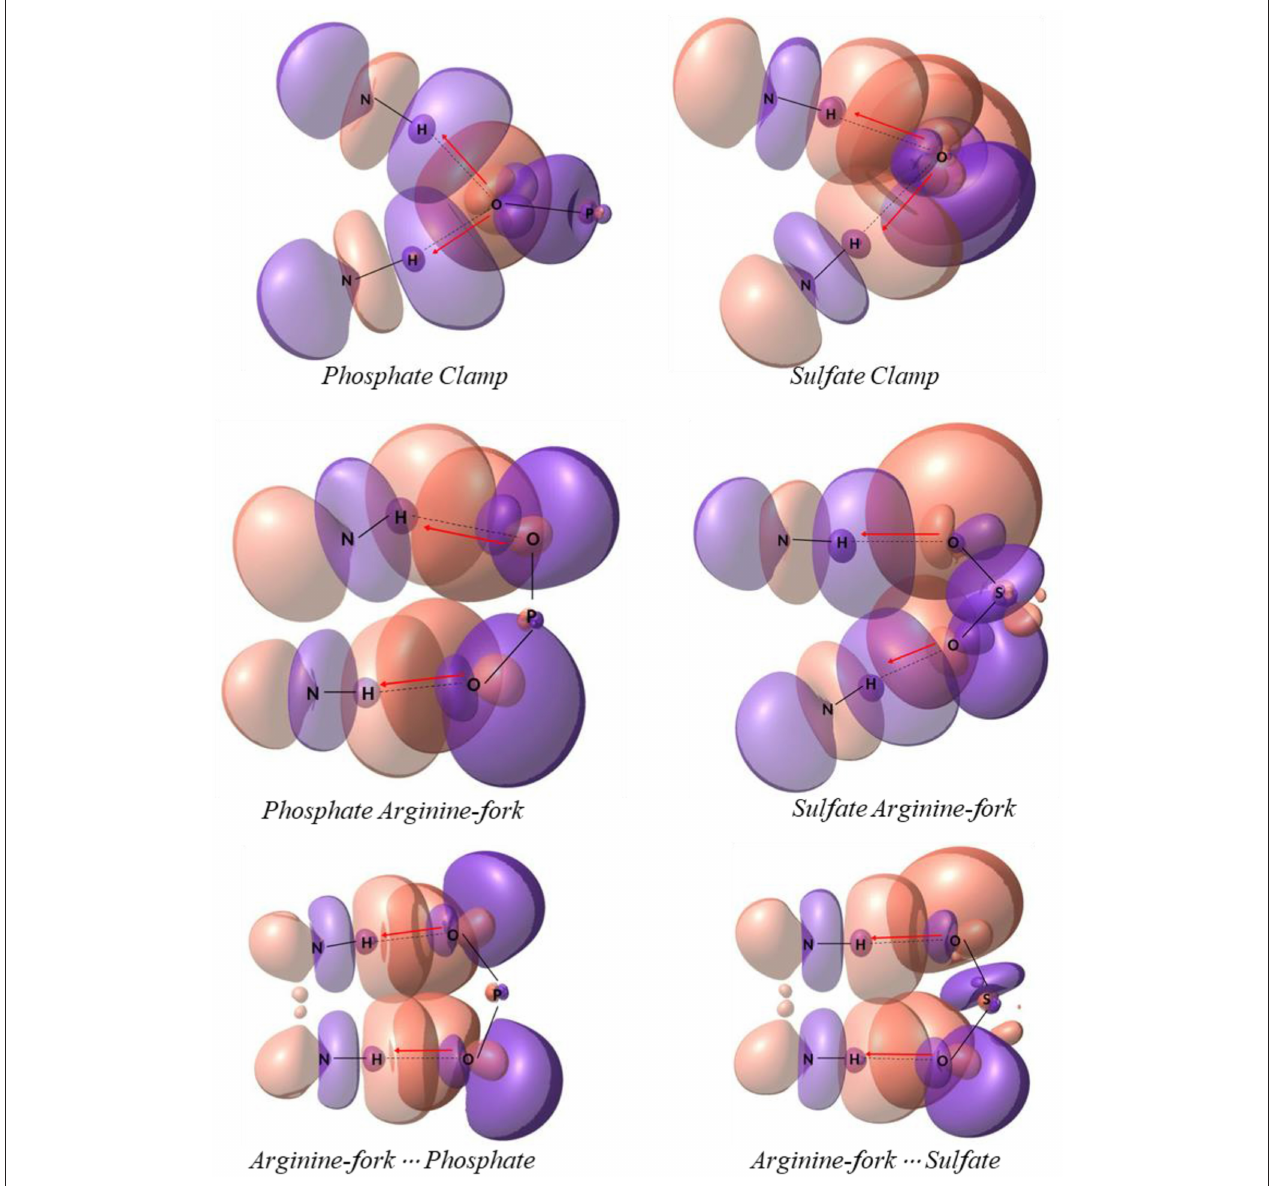
FIGURE 9 | Natural bonding orbitals of models displayed on Figure 5 . The electron donation is depicted by red arrows from oxygen atoms to N–H bond.